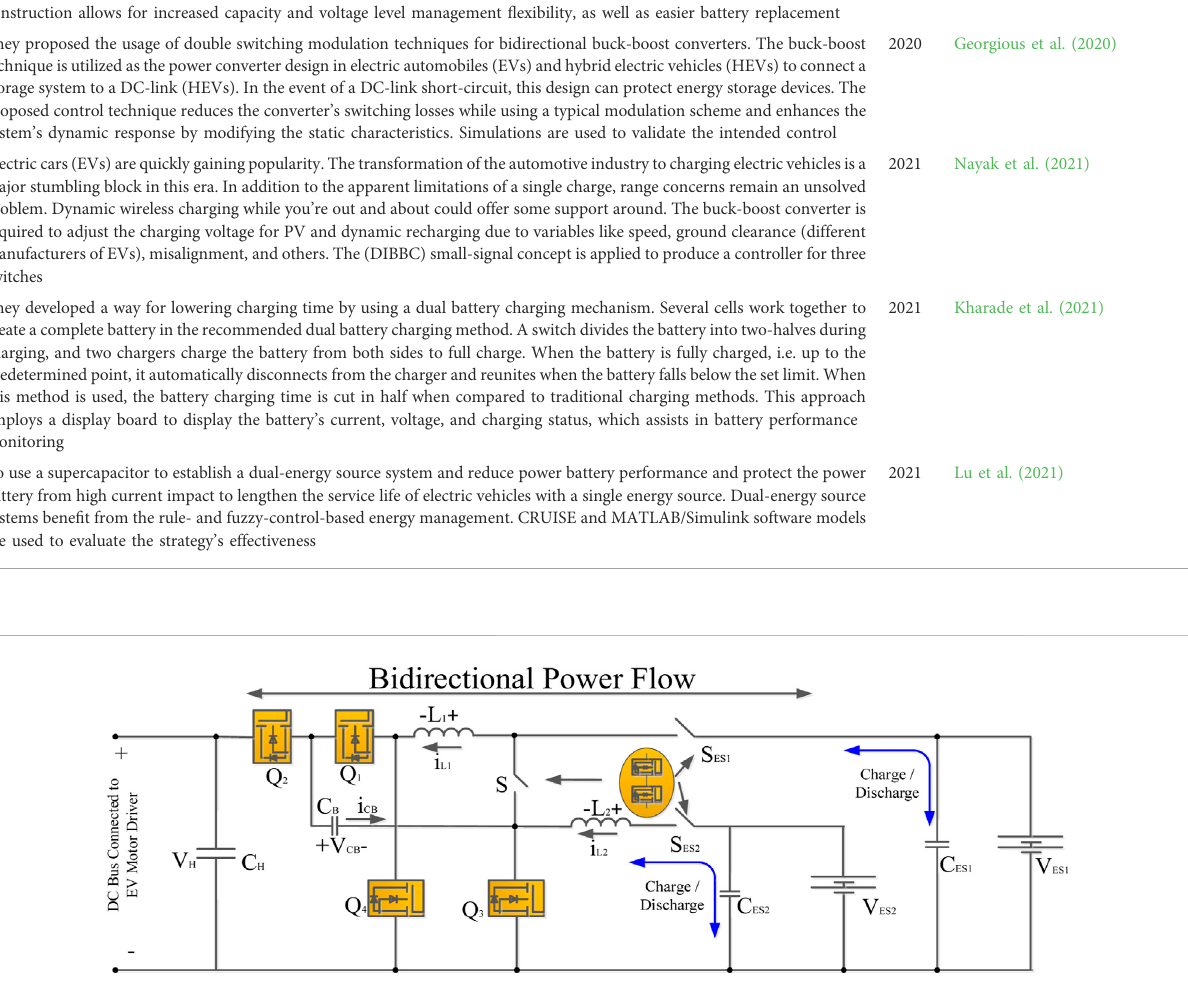
FIGURE 2 BDCC proposed architecture including dual battery